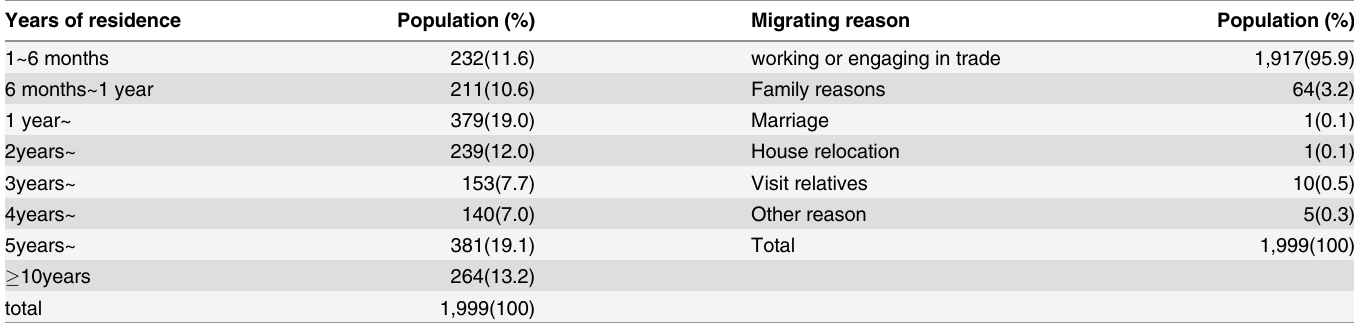
Table 2. Respondent ’ s Years of Residences and Migrating Reasons in ZhongShan in